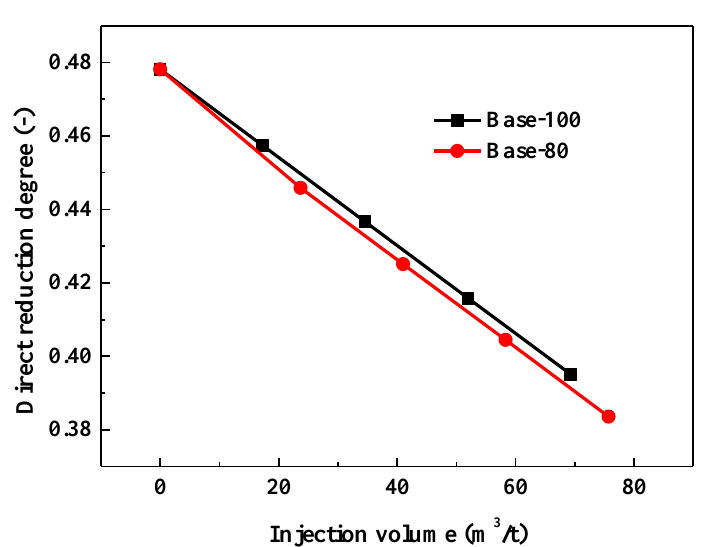
Figure 7. Direct reduction degrees of blast furnace under different suitable gas injection volumes